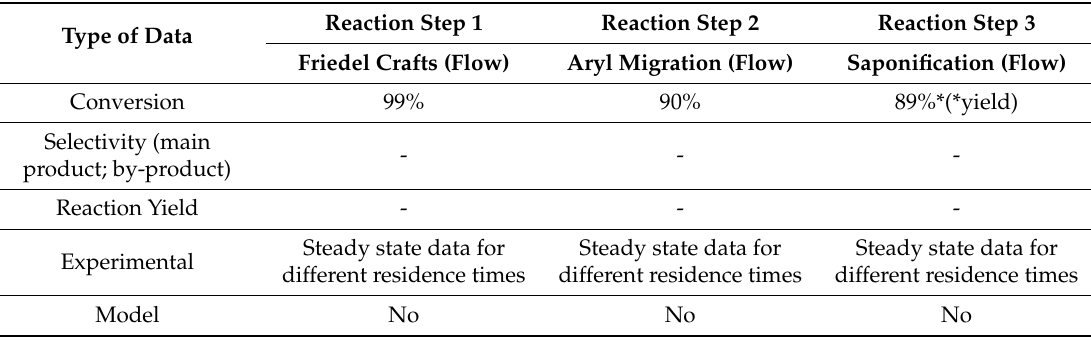
Table 14. Available experimental data as retrieved from the